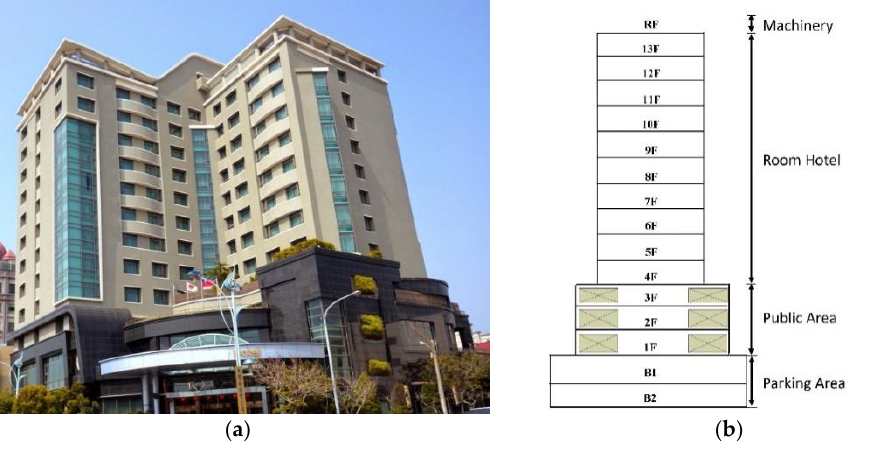
Figure 1. The investigated hotel building: ( a ) façade of the existing building and ( b ) area and eleva-